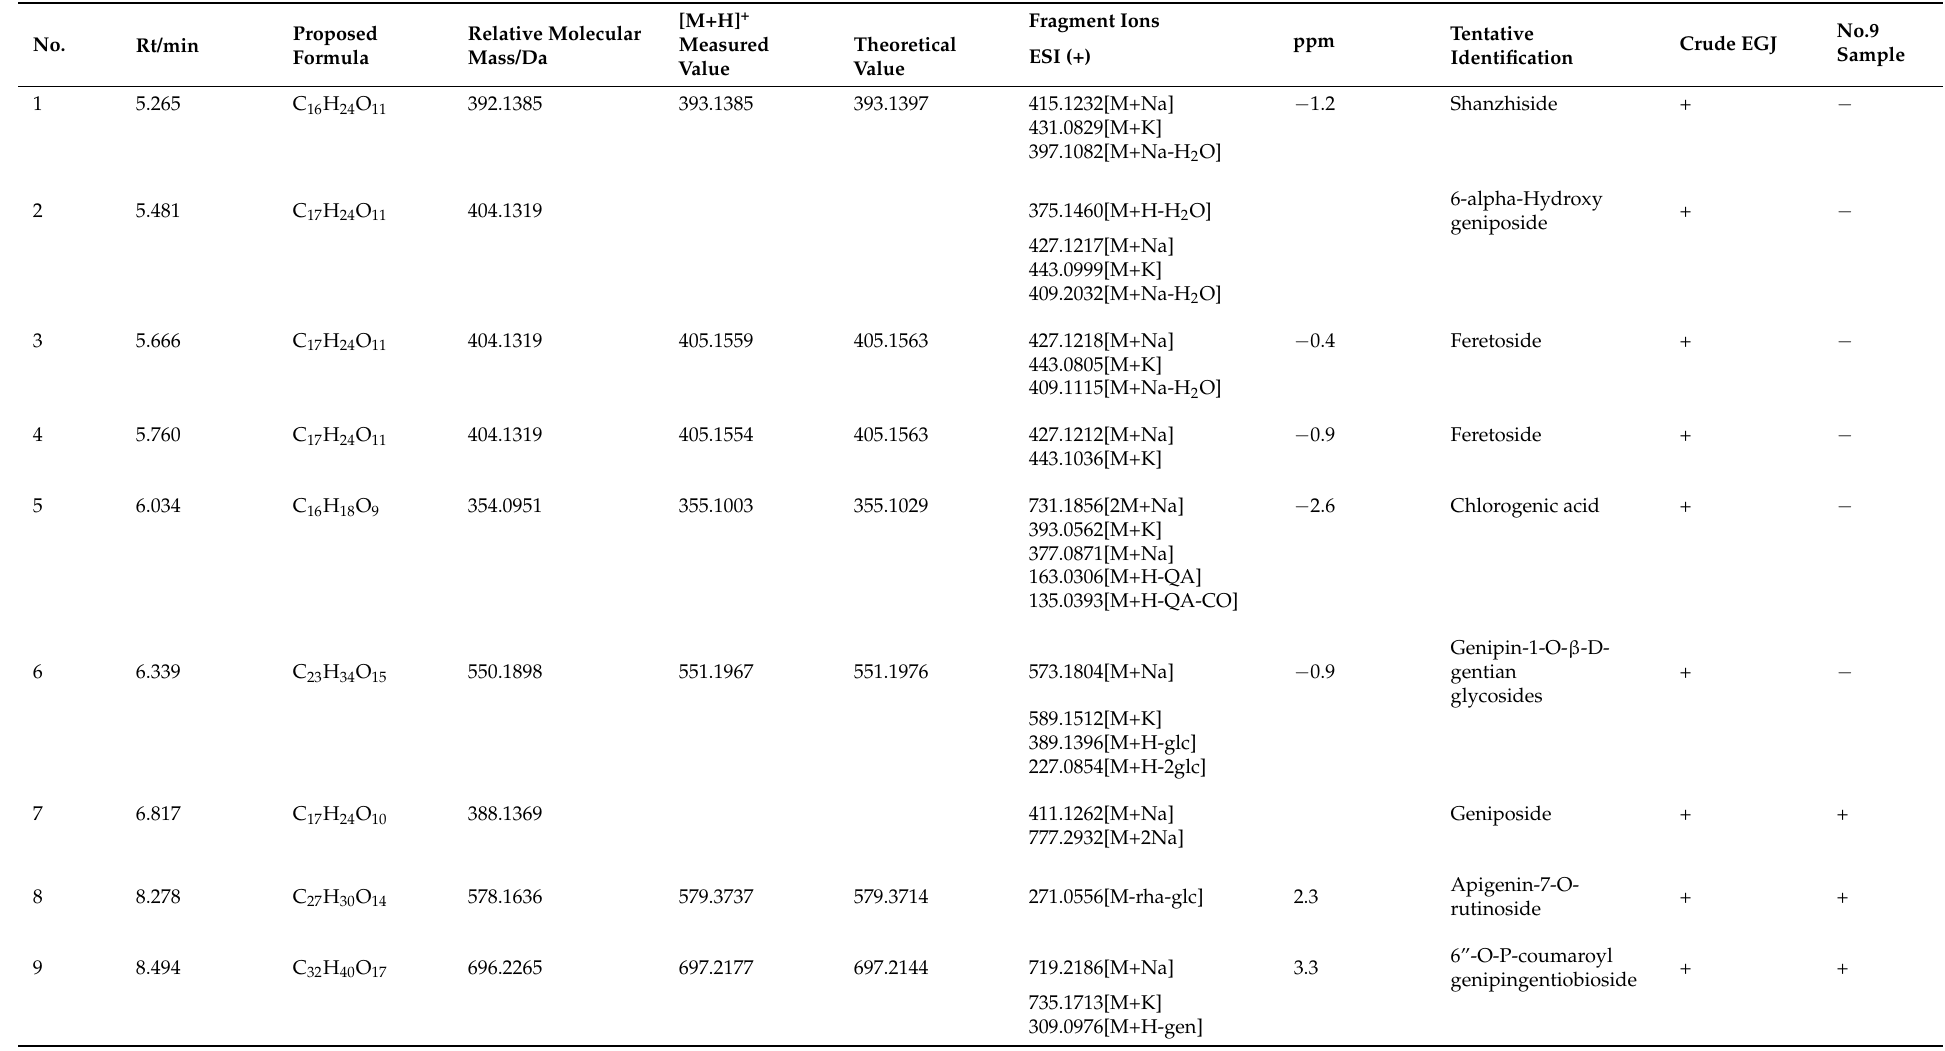
Table 1. Identification of the compounds in geniposide and crocetin using UPLC − ESI − QTOF − MS/MS in the positive ion